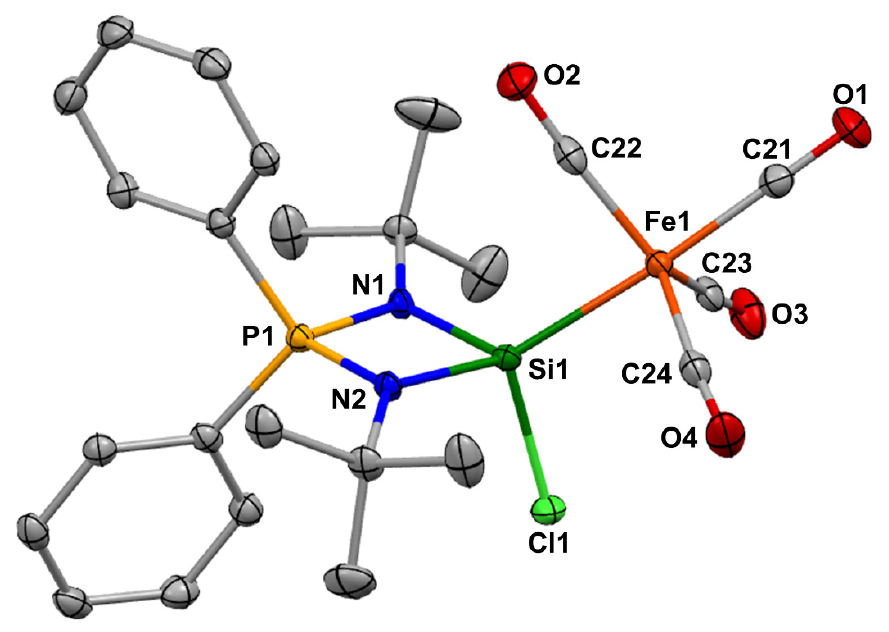
Figure 1. ORTEP [28] of 2 with thermal ellipsoids at a 50% probability. All hydrogen atoms and a molecule of THF in the unit cell were omitted for clarity.